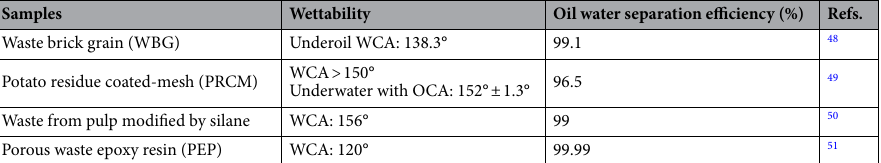
Samples Wettability Oil water separation efficiency (%)